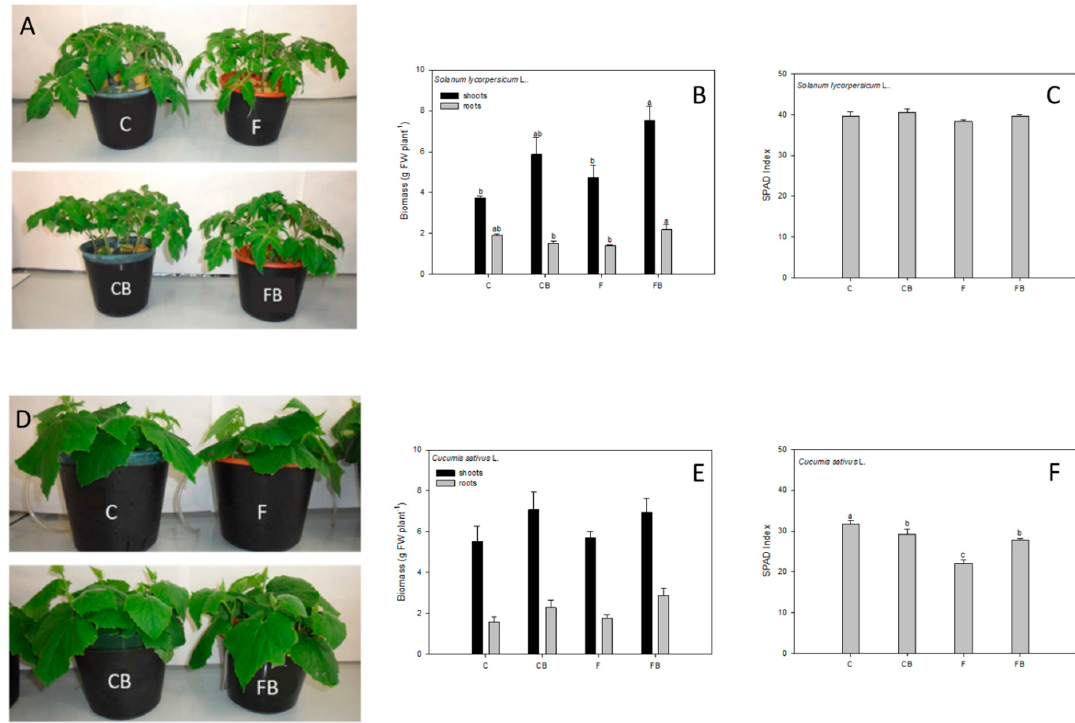
Figure 1. Growth parameters of 17-day-old tomato ( Solanum lycopersicum L.) and 22-day-old cucumber ( Cucumis sativus L.) plants grown in either a full nutrient solution supplied without or with the plant-derived protein hydrolysate (C and CB, respectively) or a Fe-deficient nutrient solution supplied without or with the plant-derived protein hydrolysate (F and FB, respectively): ( A ) representative tomato plants grown; ( B ) shoot and root biomass of tomato plants; ( C ) SPAD units of tomato plants; ( D ) representative cucumber plants; ( E ) shoot and root biomass of cucumber plants; ( F ) SPAD units of cucumber plants. Data are reported as means ± SE ( n = 3). Statistical significance was tested by one-way ANOVA analysis with the Student–Newman–Keuls post hoc test ( p < 0.001). Different letters indicate statistically different values within each plant species.